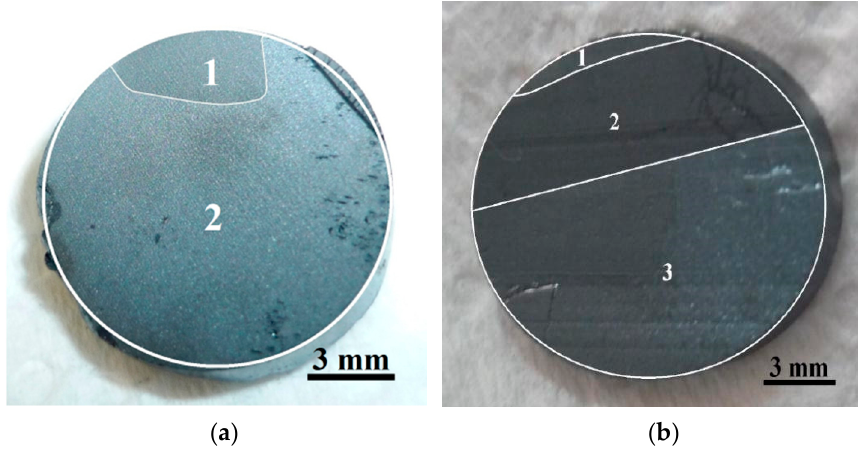
Figure 4. ( a ) Wafer of a Cd 0.90 Zn 0.10 Te ingot grown at 1.66 mm/h (orientation unknown); ( b ) [111] wafer of a Cd 0.96 Zn 0.04 Te ingot grown at 3.22 mm/h.